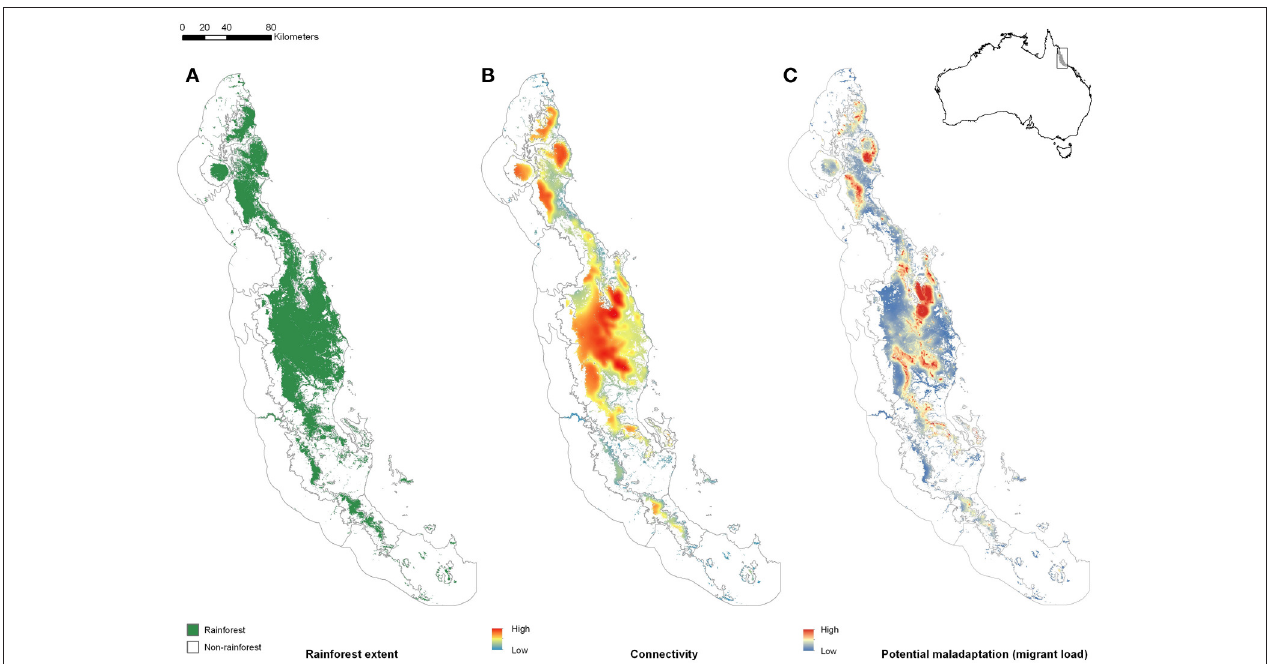
FIGURE 1 | The Australian Wet Tropics (AWT) Bioregion is located in the north-east of the continent (inset). Here, we show (A) the distribution of naturally occurring rainforest patches within the AWT prior to European settlement; (B) connectivity of extant rainforest (See Supplementary Information for Methods), and; (C) potential maladaptation (relative migrant load) as a function of connectivity and spatial heterogeneity in annual mean temperature (see Supplementary Information for